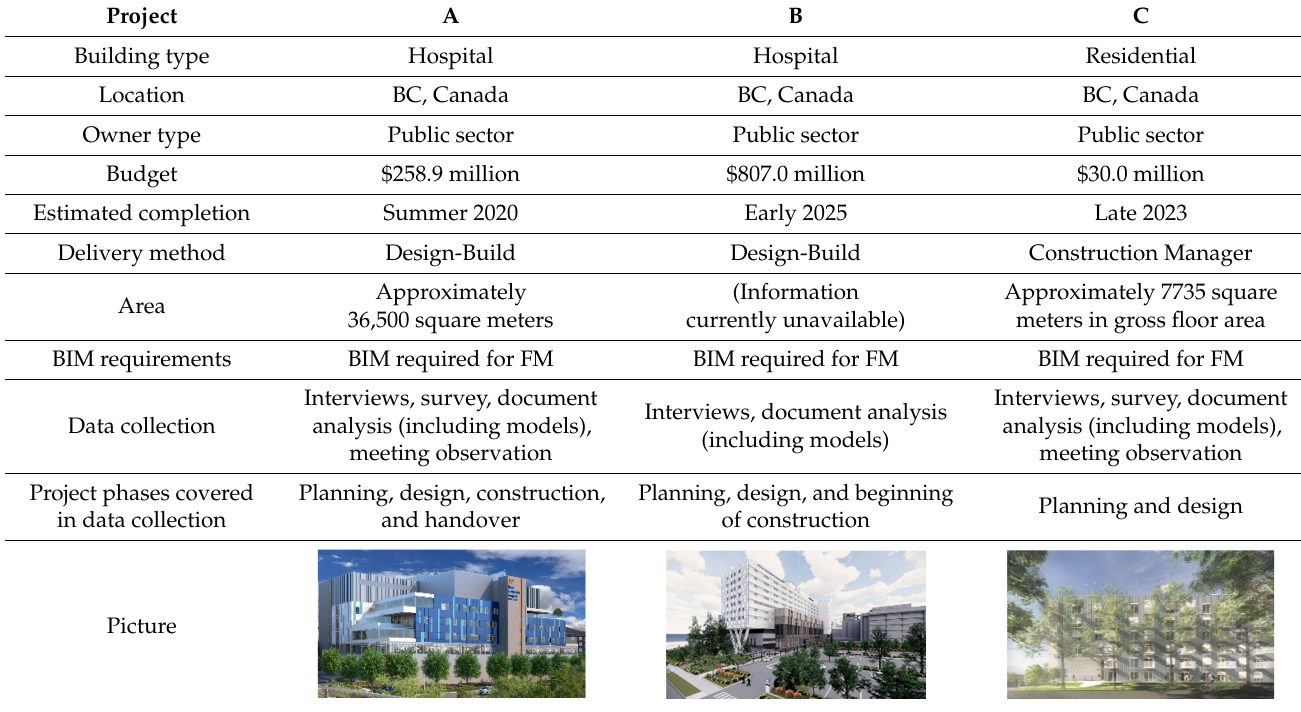
Table 3. General information about the projects used as data